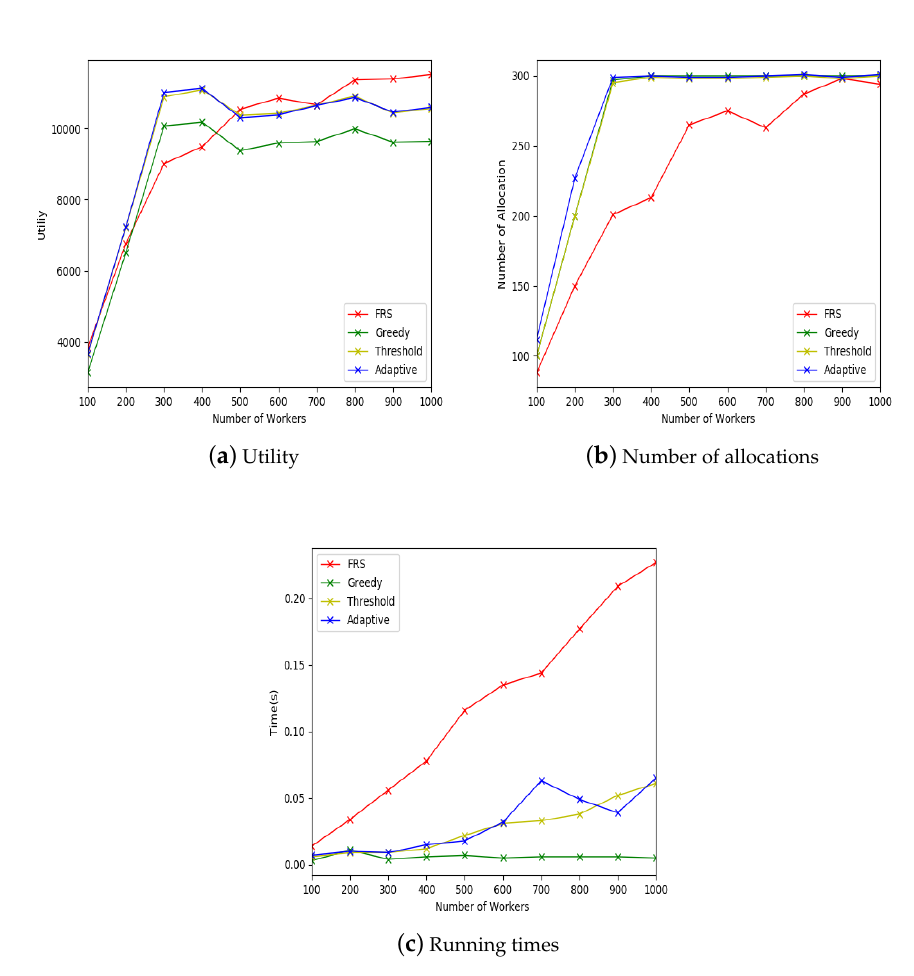
Figure 7. Effect of small-scale data.